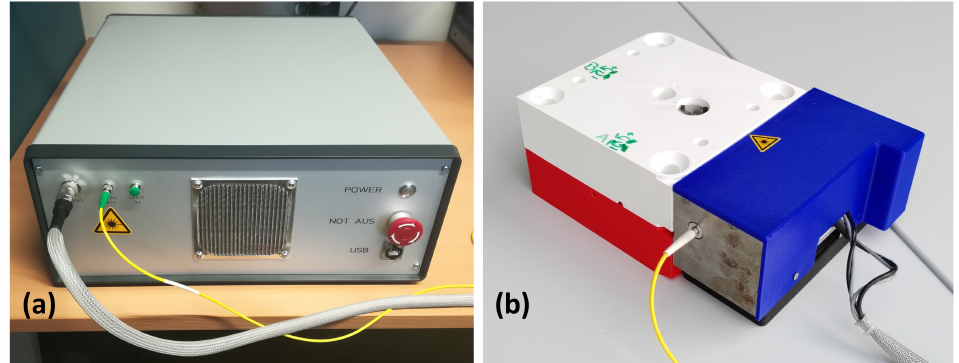
Figure 4. ( a ) Front view of the OCT device. All components except the probe head are built into a 19-inch housing. ( b ) Probe head (with a blue 3D-printed cover) mounted to the mock-up mould (fixed part in red and movable part in